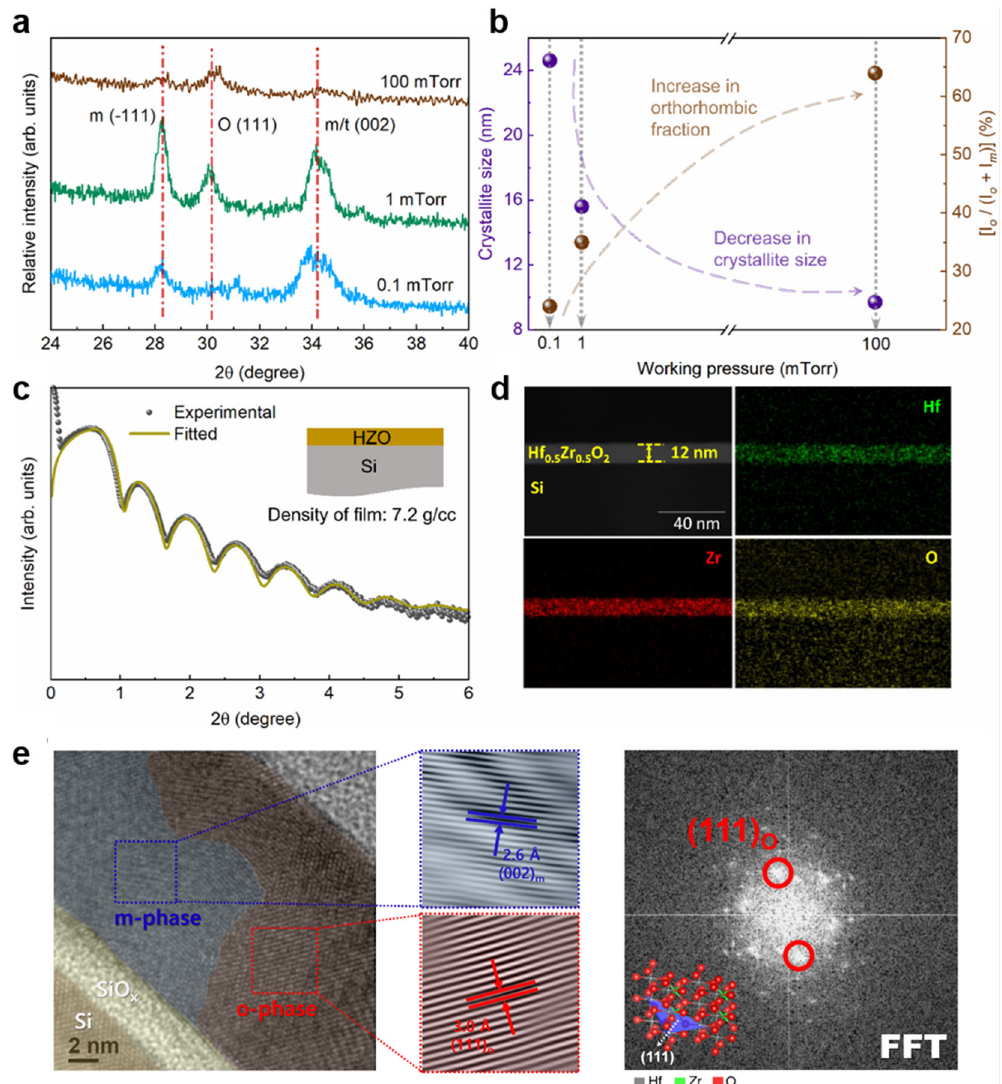
Fig. 2 Structural analysis of PLD-grown HZO on Si. a XRD diffractograms of HZO thin fi lms deposited at different working P O crystallite size and the fraction of o-phase estimated from Scherrer equation and relative peak intensities. c XRR results for an as-deposited = 1 mTorr) HZO thin fi lm on Si ( d ) TEM cross-sectional micrograph and EDS elemental mapping of HZO thin fi lm; ( e ) Cross- (working P O 2 sectional HR-TEM micrograph, fi ltered inverse FFT, and FFT pattern of the selected